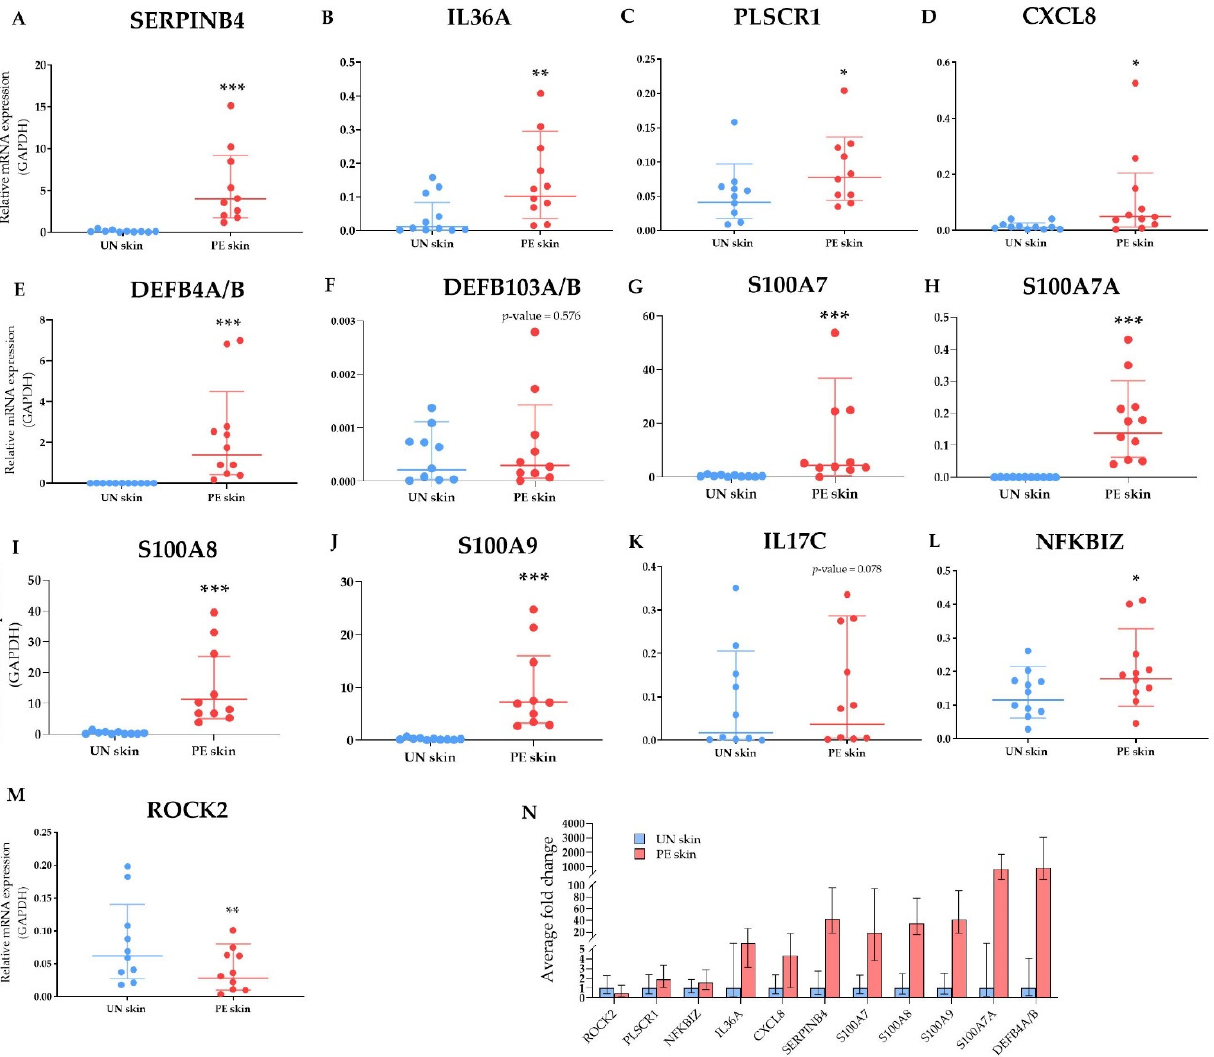
Figure 7. Quantitative multiplex Real-Time PCR analysis of DEGs and upstream regulators. The mRNA level of each gene was calculated relative to GAPDH , the housekeeping gene. ( A – J ) The relative RNA expression of selected DEGs. ( K – M ) The relative mRNA expression levels of selected upstream regulators. ( N ) The fold change of significantly altered genes. All graphs were designated by geometric mean and standard deviation. The significance was determined using *; * p < 0.05, ** p < 0.01 and *** p < 0.001. n ≥ 10 for each gene. CXCL8, C-X-C motif chemokine ligand 8; DEFB103A/B, defensin beta 103A/B; DEGs, differentially expressed genes; IL17C, interleukin 17C; NFKBIZ, nuclear factor kappa B inhibitor zeta; PE skin, peripheral edge of lesional skin; PLSCR1, phospholipid scramblase 1; ROCK2, rho-associated kinase 2; S100A7, S100 calcium binding protein A7; SERPINB4, serpin family B member 4; UN skin, uninvolved skin.